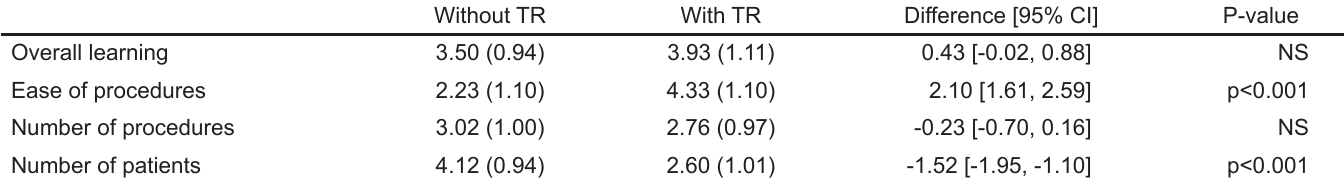
Table 1. Medical student evaluation of emergency medicine clerkship experiences with and without the presence of the teaching resi- dent (TR). Five-point scale responses were converted to ordinal numbers where 1=“Poor” and 5=“Excellent”. Values are reported as mean (SD). P values were determined by a two-tailed, unpaired Student’s t-test. The response rate was 40/71